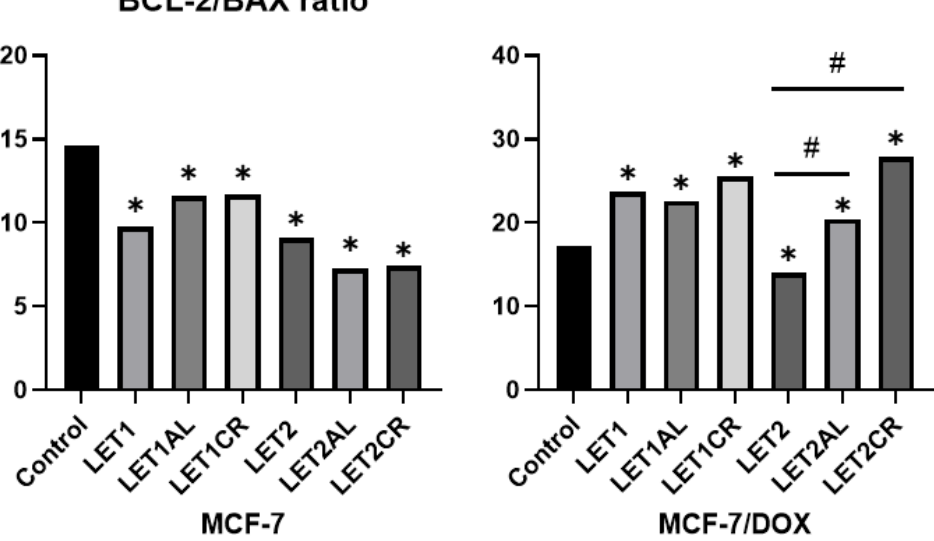
Figure 7. Effect of letrozole and its combination with metalloestrogens in the Bcl-2/BAX ratio. LET1 = 10 µM; LET2 = 100 µM; and Al/Cr(III) = 100 µM. The results are presented as mean, n = 3; p < 0.05; * statistically significant difference from control; # statistically significant difference from aromatase inhibitor alone. Table 4. Bcl-2/BAX ratio values in MCF-7 and MCF-7/DOX cell lines after exposure to letrozole alone or in combination with metalloestrogens. The results are presented as mean, n = 3; p < 0.05.